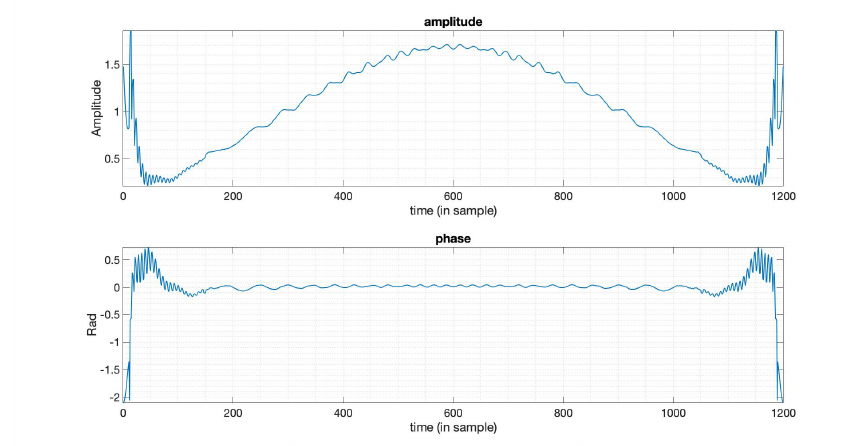
Figure 6. The amplitude and phase of the optimized window function in Figure